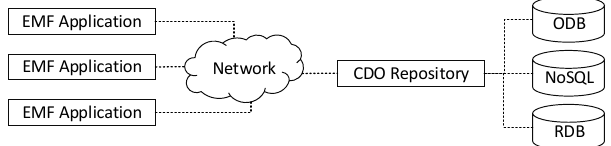
Figure 4. CDO Repository Diagram [9].